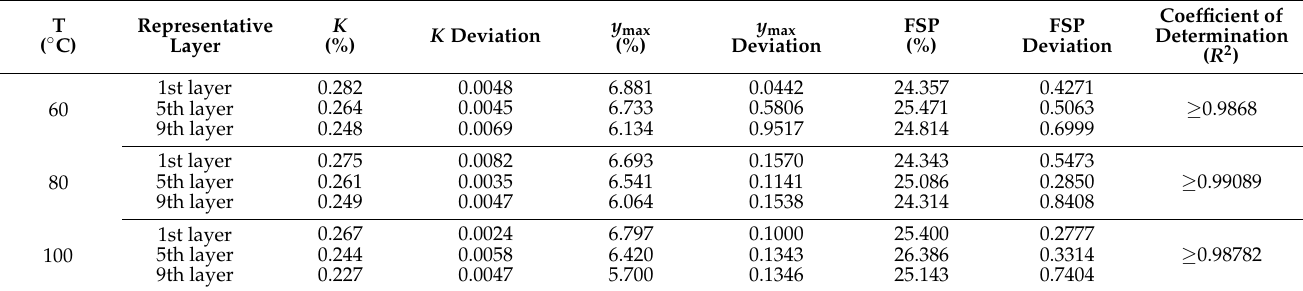
Figure 2. Relationship between free shrinkage and moisture content of representative layer strips in Mongolian Scotch pine at different temperatures. Table 3. Fitting parameters of the free drying shrinkage law of representative layer test strips in Mongolian Scotch pine sawn timber.